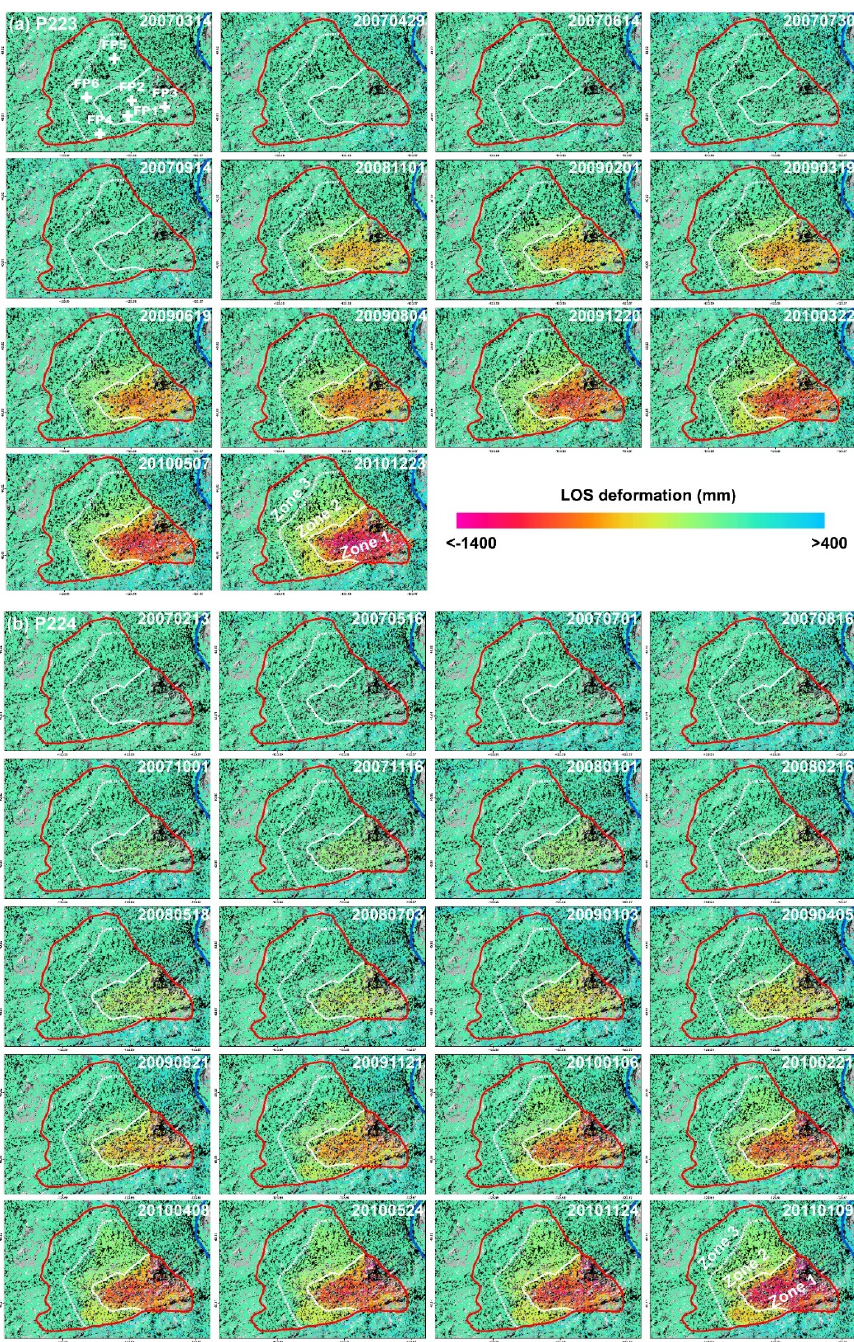
Figure 5. Cumulative deformation along the radar LOS direction for ( a ) Path 223 (P223) from 14 March 2007 to 23 December 2010 with the reference SAR acquisition date 20070314 and ( b ) Path 224 (P224) from 13 February 2007 to 9 January 2011 with the reference SAR acquisition date 20070213. The color scale shows the LOS deformation in millimeters and the white line represents the boundary of di ff erent sections inferred by the InSAR-derived deformation pattern and the compressional morphologic features. It is worth noting that the positive values indicate the landslide motion toward the satellite sensor, while the negative values represent the landslide motion away from the satellite